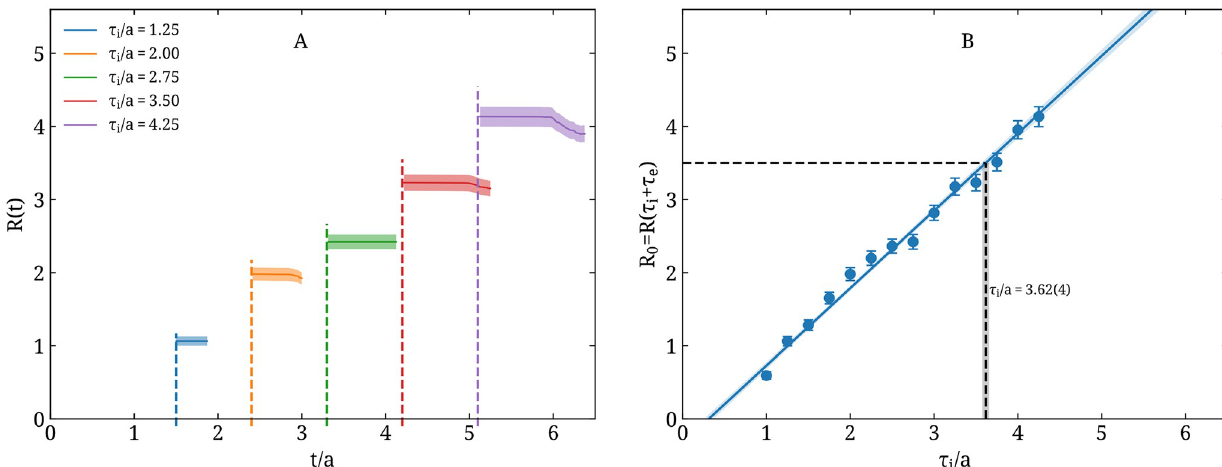
Fig 1. Setting the particle model time scale. Left panel (A): The average number of transmissions per individual as a function of time R ( t ) for representative values of the infectious period in simulation time units ( τ i / a ), namely for τ i / a = 1.25 (blue), 2 (orange), 2.75 (green), 3.5 (red), and 4.25 (purple). The dashed vertical line shows t = τ i + τ e for each case. The errorband in R ( t ) is from 256 statistics. Right panel (B): The basic reproduction number R 0 obtained as R ( τ + τ ) from the particle model as a function of the infectious period in simulation time units ( τ i e to τ e = τ i /5. The blue line and band are the result of a linear fit to R 0 . The horizontal dashed line shows R 0 = 3.5, used to set the scale a , via τ i = 10 days.